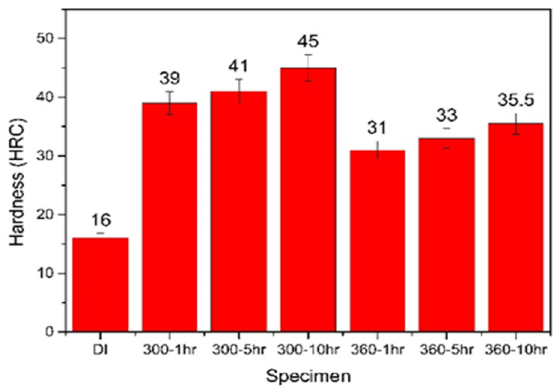
Figure 6. Comparison of the hardness values among as-cast DI and the various ADIs.